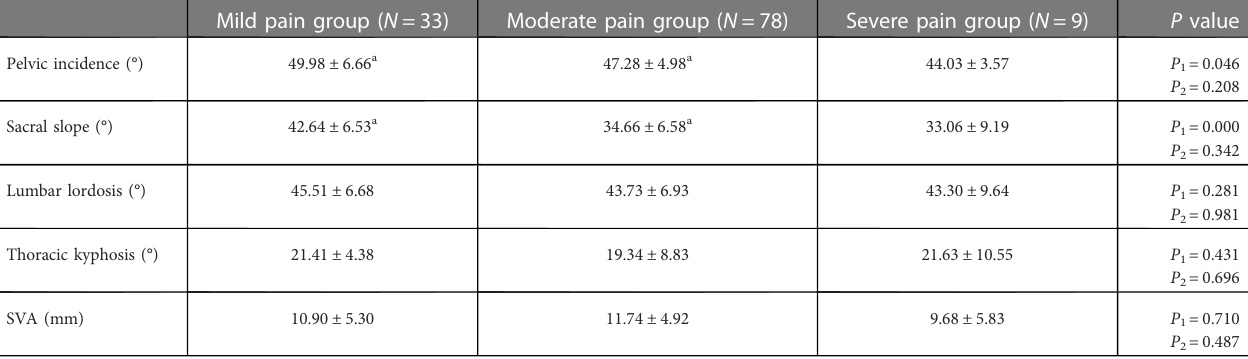
TABLE 3 Results of sagittal spino-pelvic alignment parameters between mild to severe pain subgroups in PD